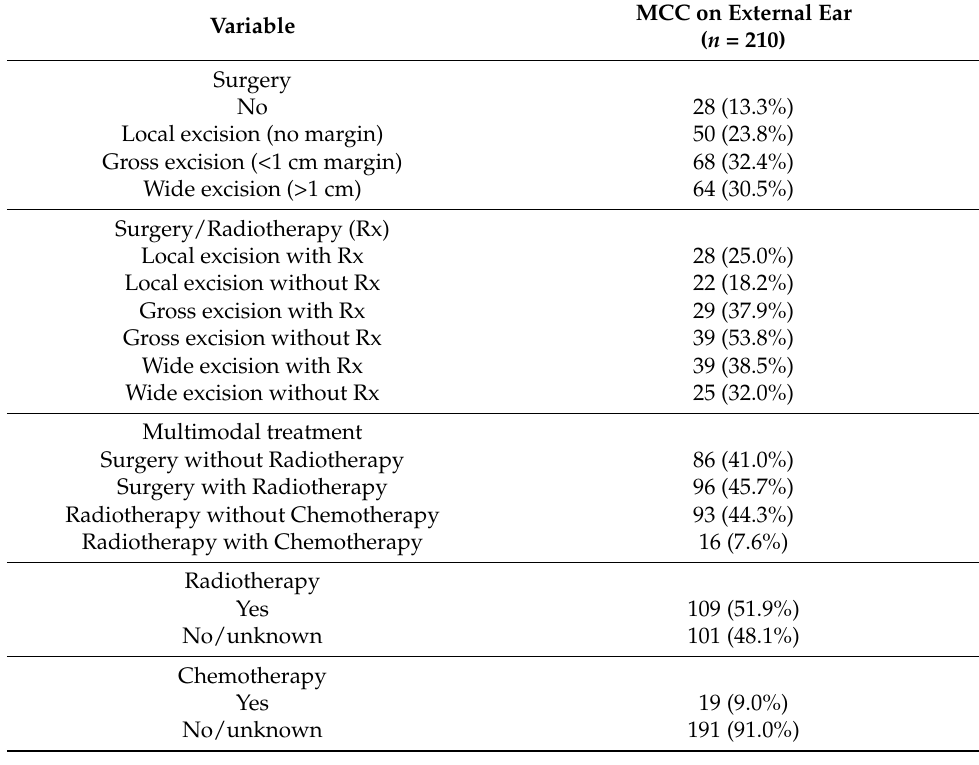
Table 2. Treatment characteristics of the study population.